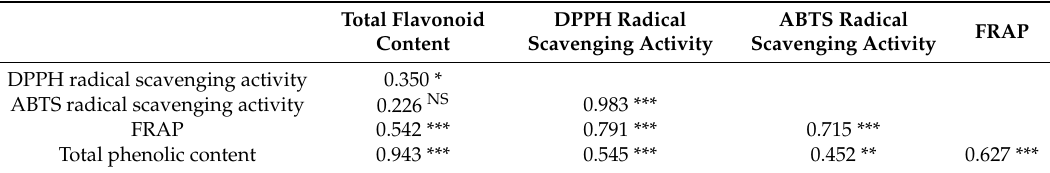
Table 5. Correlation coefficient ( R ) between total phenolic content, total flavonoid content, ABTS radical scavenging activity, DPPH radical scavenging activity, and ferric reducing antioxidant power (FRAP) values of yacon leaves which were extracted with ohmic-assisted decoction (OH-DE) and decoction (D) values of yacon